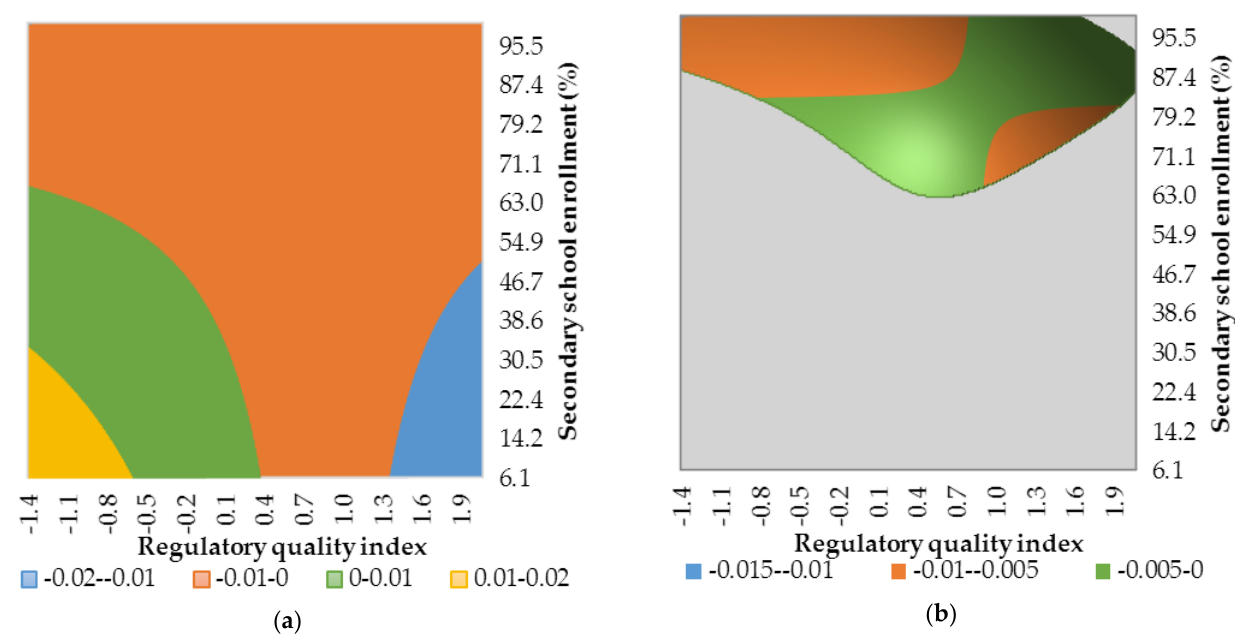
Figure A4. Conditional effect of financialisation on growth based on Est. 4 in Table A2. ( a ) Estimated conditional slope coefficient over the whole range of observed values for institutional quality and development level. ( b ) Estimated statistically significant conditional slope coefficient. Gray represents a combination of institutional quality and development level for which effect of financialisation on growth is statistically insignificant. Source: authors’ contributions.